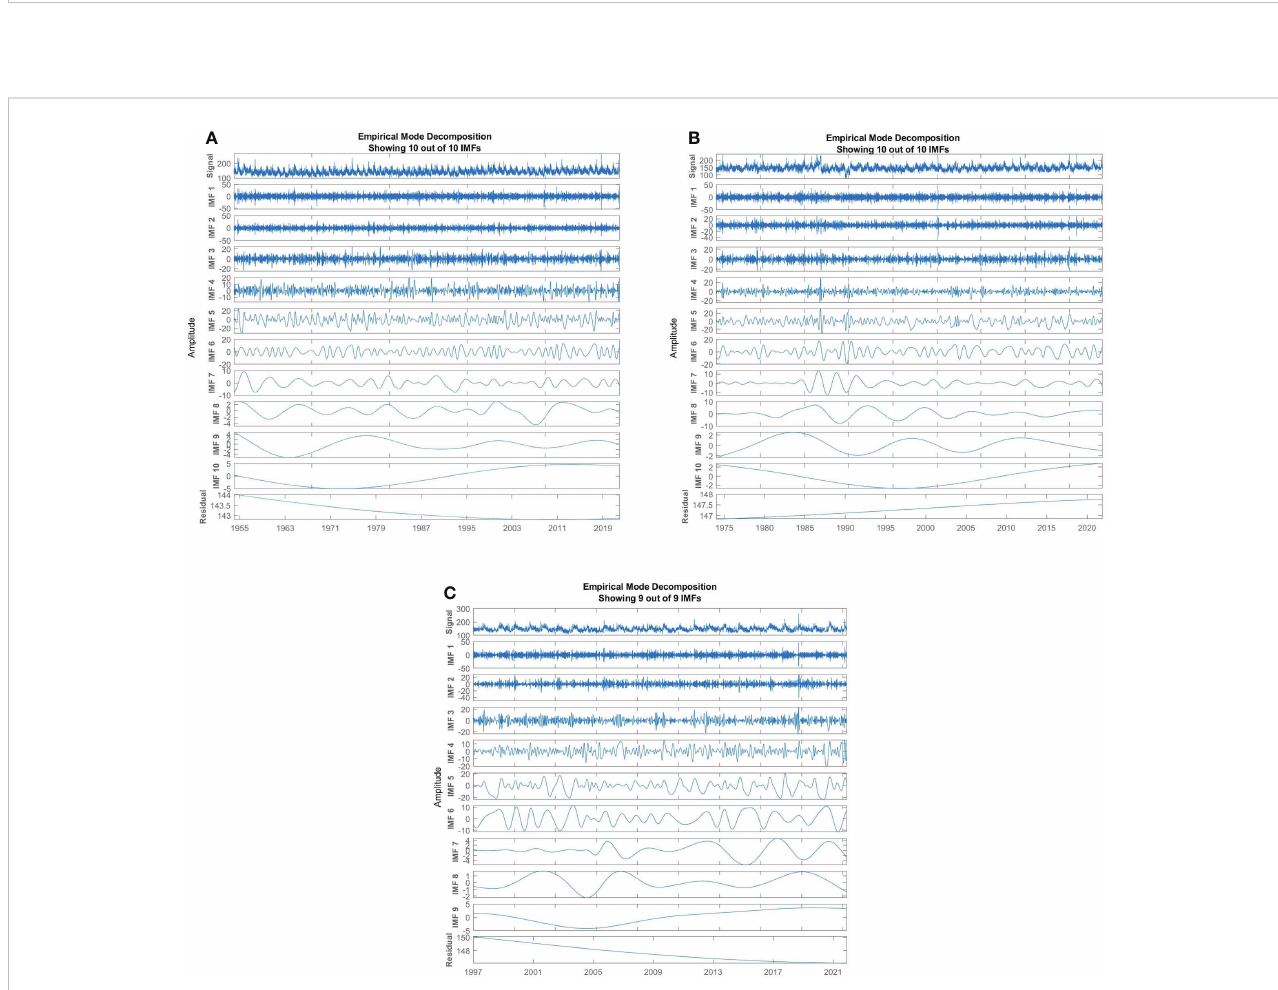
FIGURE 5 EMD results of three tide gauge stations. (A – C) show the original daily sea-level signal (units: cm), a series of IMF components, and residual of QUB, TBT, and SPW tide gauge sites,